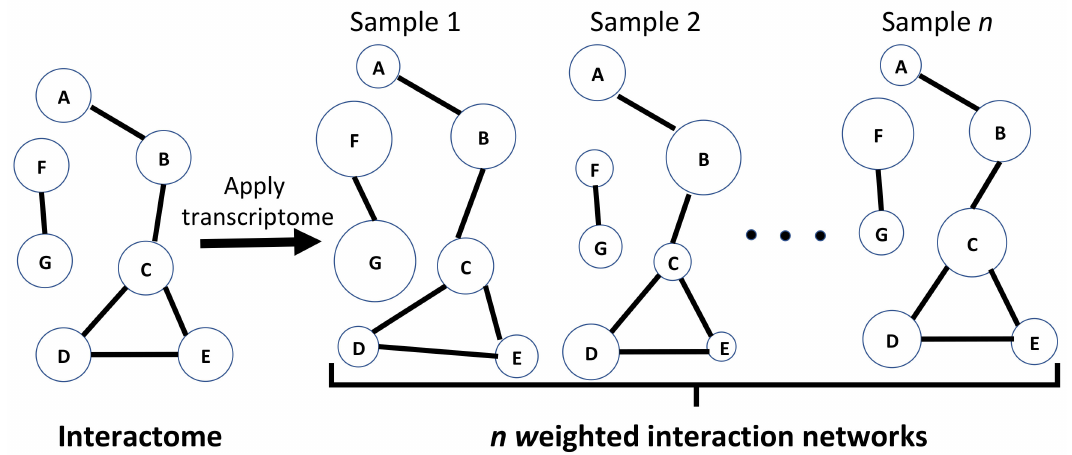
Figure 2. A schematic illustration of the method to calculate the average values of the Gibbs free energy over a number of samples. Here, n represents the number of samples